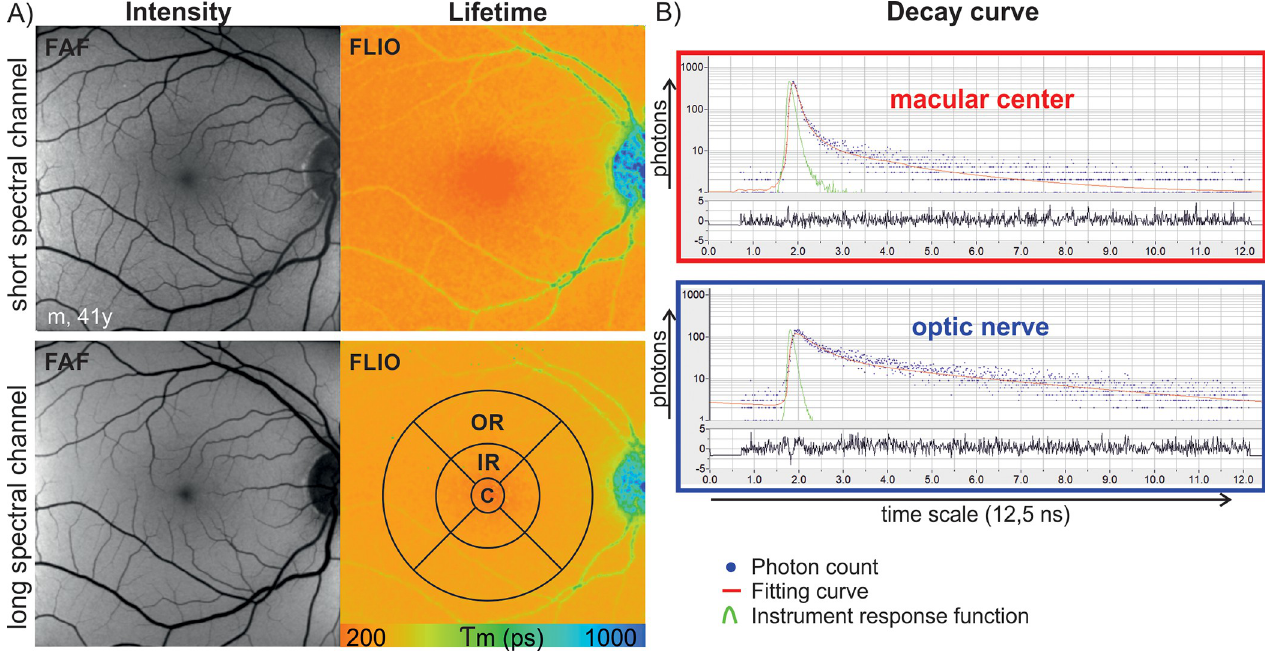
Fig 1. Fluorescence lifetime imaging ophthalmoscopy (FLIO) in the healthy eye. A) Fundus autofluorescence intensity (FAF) and fluorescence lifetime (FLIO) images in the short (498–560 nm) and the long (560–720 nm) spectral channel. A standard ETDRS grid was used for quantitative analysis of individual grid areas (C = Center (diameter d = 1mm), IR = inner ring (d = 3mm), OR = outer ring (d = 6mm)). B) Corresponding scatter plots with overlaid decay histogram illustrate the decay times of individual locations such as the macular center (red square), and the optic nerve head (blue square). X-axis: Time line, y- axis: Number of detected photons (logarithmic scale). Below the decay curve, the corresponding residuals are displayed, indicating how precise the raw data is approximated by the fitting curve. Blue dots: Number of photons at this specific point in time at this location (binning fact(1)or = 1); red curve: Fitting line; green line: Instrument response